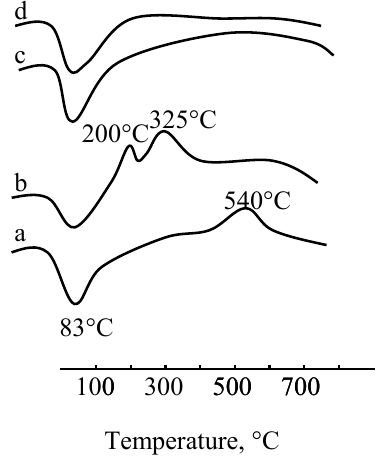
Figure 3 . DTA spectra for activated carbon-supported molybdenum-based catalysts. Samples are as following: ( a ) Mo(18)/AC(D); ( b ) Mo(18)-K(1.2)/AC(D); ( c ) Mo(18)/AC(C); and ( d ) Mo(18)- K(1.2)/AC(C).